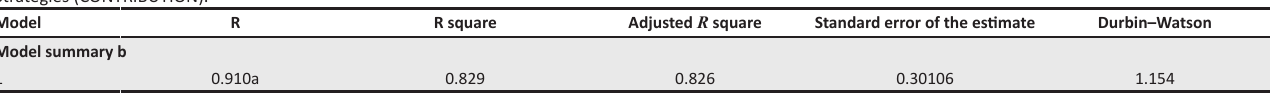
TABLE 5a: Regression analysis: Adoption of Digital Human Resource Management Strategies (USE) factors and Adoption of Digital Human Resource Management Strategies (CONTRIBUTION). Model